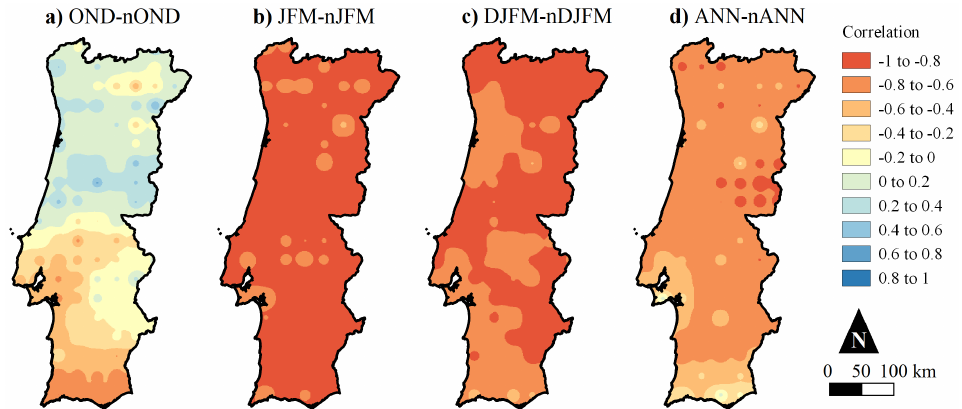
Figure 5. Teleconnection between the grid-point rainfall trends and NAOI trends from 1919–2019. Spatial distribution of the Pearson correlation coefficient, r , between the progressive-trend series, u ( t ) , of OND, JFM, DJFM and ANN rainfall; and nOND, nJFM, nDJFM and nANN NAOI, respectively (IDW2 interpolation method used for mapping).